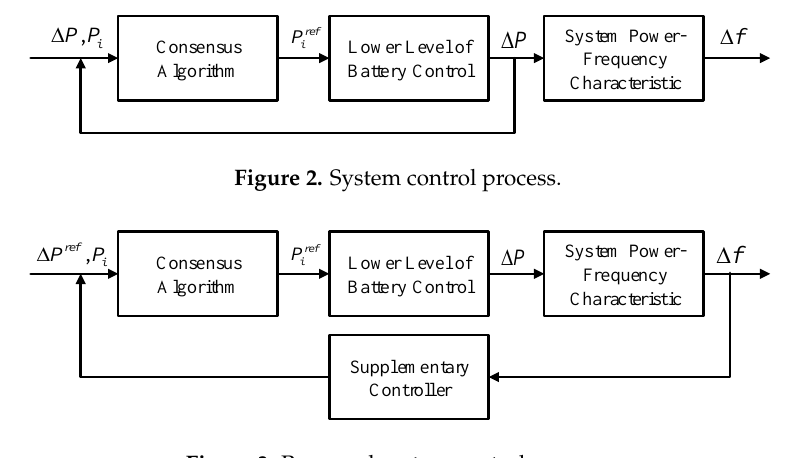
Figure 3. Proposed system control